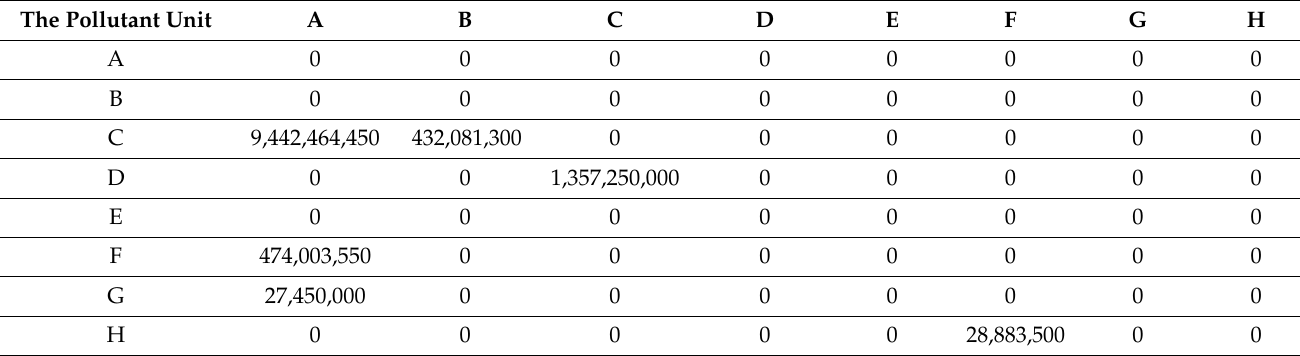
Table 5. Trading cost for units